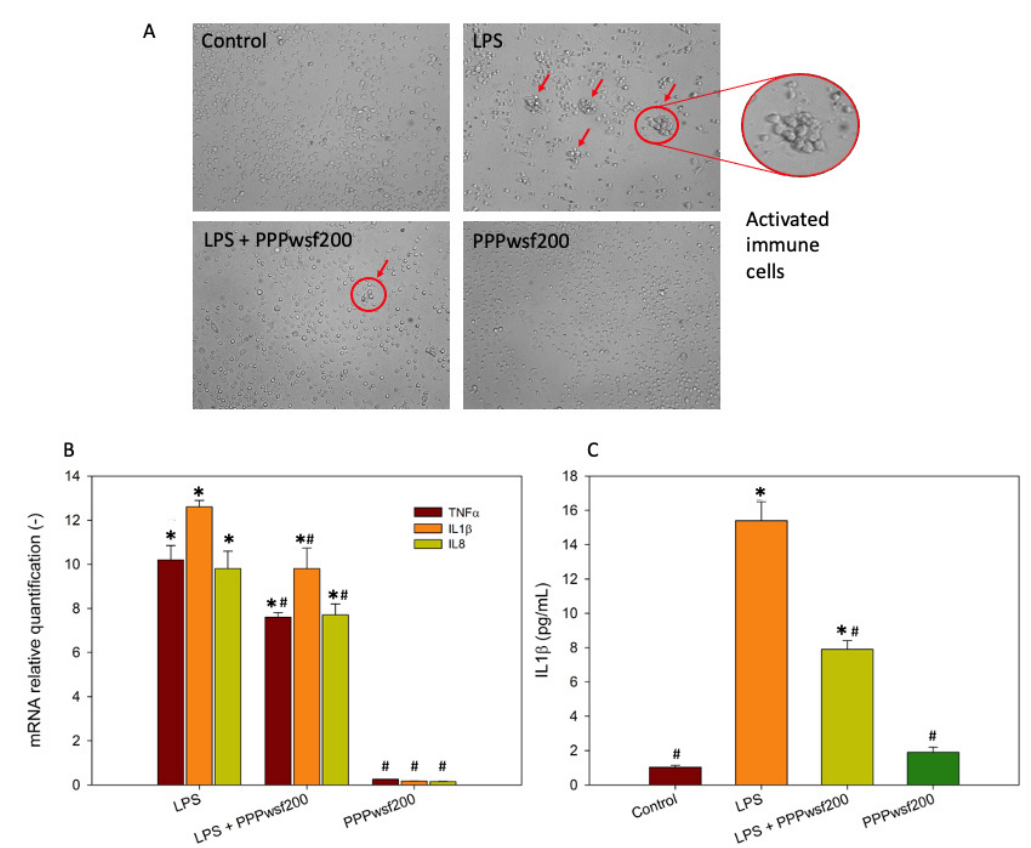
Figure 4. PPPwsf co-treatment in PBMCs: ( A ) Morphological analyses of cells activation by clustering formations after 4 h treatment with LPS 1 μ g/mL, LPS 1 μ g/mL + PPPwsf 200 μ g/mL, and PPPwsf 200 μ g/mL. Red circles indicate the clusters of activated immune cells. Magnification 20X. ( B ) Immunological response evaluated by mRNA quantification of TNF α , IL1 β , and IL8. ( C ) Level of interleukin IL1 β measured by ELISA assay. * Control vs. other treatments ( p ≤ 0.05); # TBH samples vs. control and other treatments ( p ≤